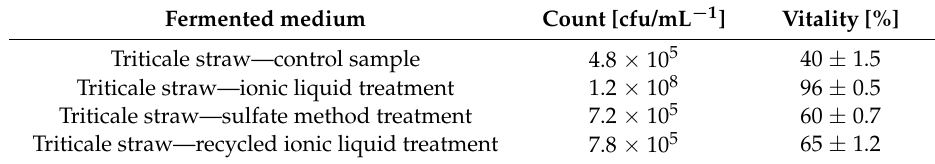
Table 1. Count and vitality of Saccharomyces cerevisiae Ethanol Red yeast cells in the tested